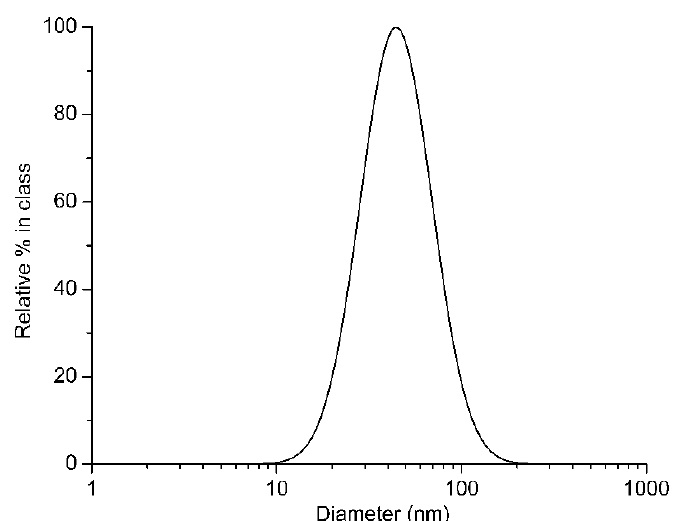
Figure 3. Particle size distribution of the TiO 2 nanoparticles (NPs), obtained from the dynamic light scattering (DLS) analysis.